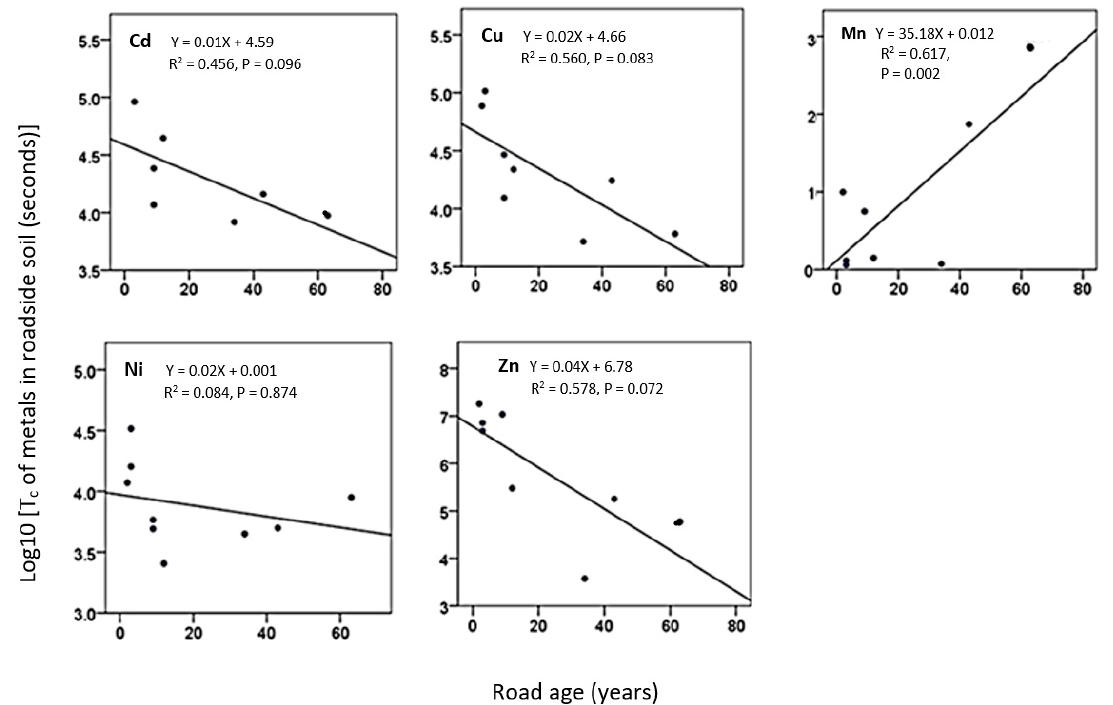
Figure 1. The relationship between roadside soil metal dissociation time Tc (seconds) and the age of the adjacent roads representing soil exposure to vehicular emissions (years). R 2 = linear correlation. Please note that in total 9 data points are included for each element, although some points overlap and are not